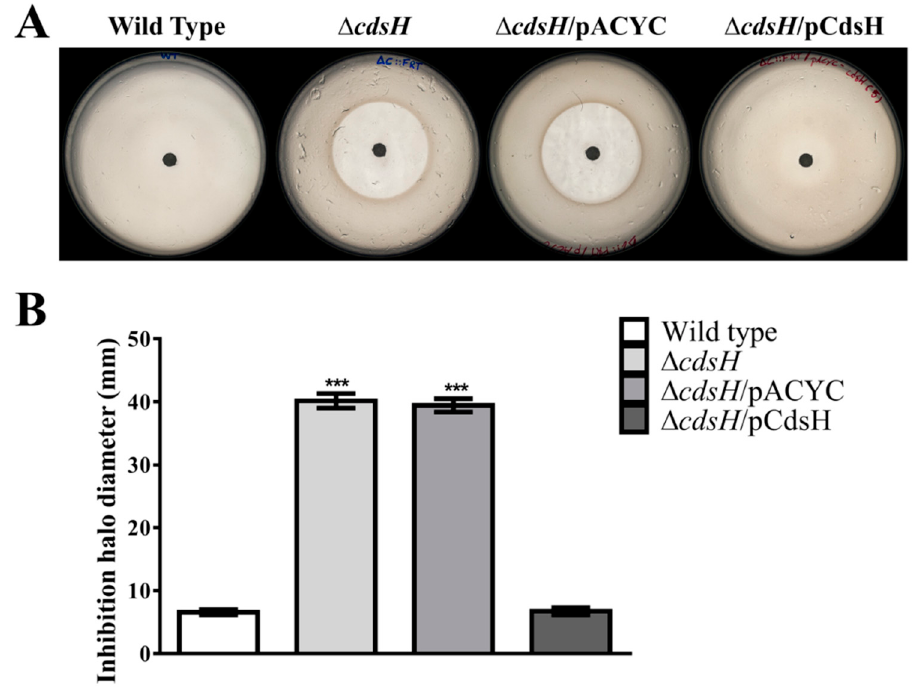
Figure 1. Inhibitory effect of cysteine in minimal medium (M9-glucose) under aerobic conditions. Overnight cultures in M9-glucose of S . Typhimurium strains were used to generate an agar-agar (0.7%) layer with approximately 10 6 CFU. A filter-paper disc was placed over the layer and loaded with 15 µL of 0.5 M cysteine solution. ( A ) Inhibition haloes generated by cysteine on wild type, Δ cdsH mutant, ∆ cdsH / pACYC (empty vector), and ∆ cdsH / pCdsH (complemented strain). ( B ) Graphic representation of inhibition haloes generated by cysteine in A). ANOVA test (post hoc: Tuckey’s test) was performed (error bars represent standard error of the mean, n = 7; ***, p < 0.001 in comparison with the wild type strain).